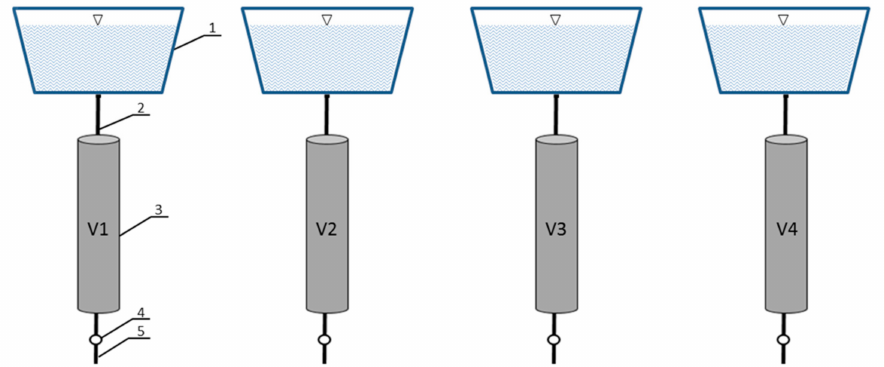
Figure 1. Setup of the column experiment: ( 1 ) hypolimnetic water reservoir, ( 2 ) alimenting pipe, ( 3 ) column bed, ( 4 ) regulating valve and ( 5 )–discharge tube. V1: column filled with lightweight expanded clay aggregate (LECA) only, and V2–V3: columns filled with LECA and limestone (LS) (volumetric share of LS: 25%, 50% and 75%, respectively).